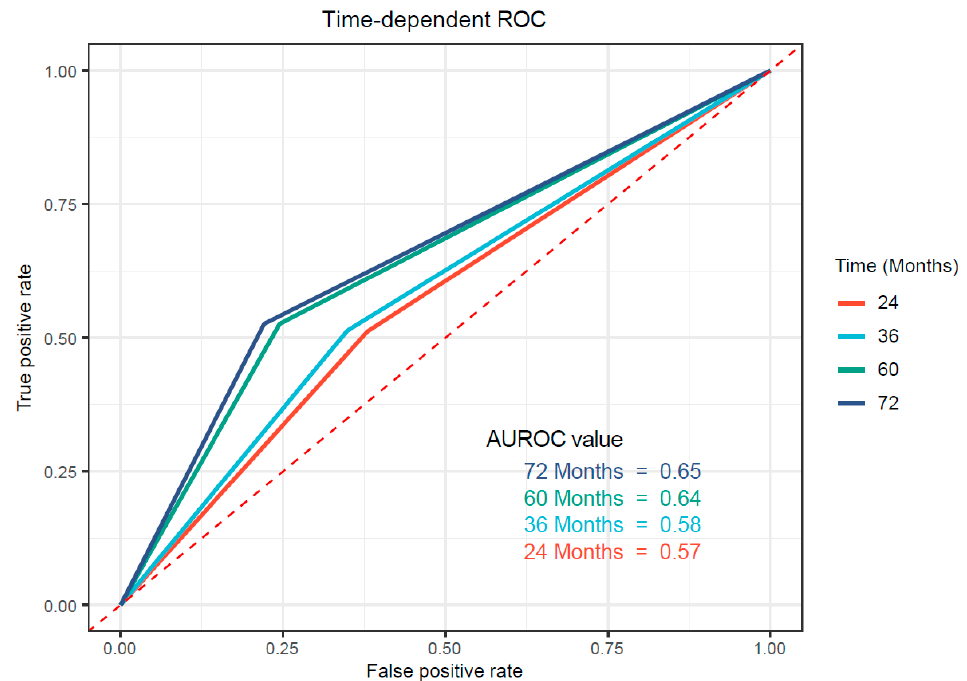
Figure 2. Predictive ability of NMPR in resectable esophageal squamous cell carcinoma by ROC curves in 24 months, 36 months, 60 months and 72 months in the training cohort. NMPR, neutrophil–mean-platelet-volume–platelet ratio.